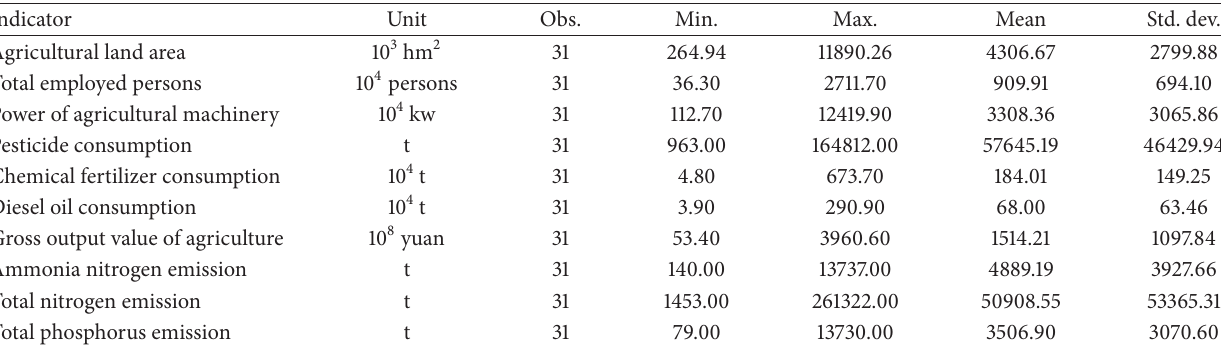
Table 3: Statistical description of input-output indicators in 31